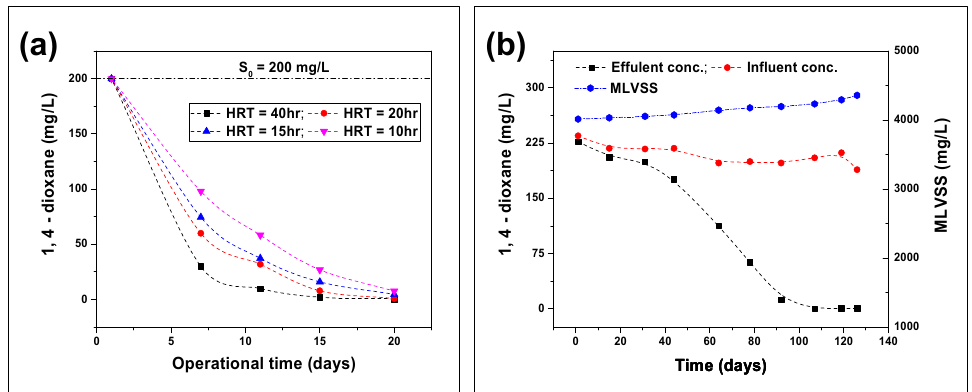
Figure 6. Lab-scale operation of the PFR plant for 1,4-dioxane biodegradation under a mixed culture grown on the BSM and sludge mixture using 1,4-dioxane as a substrate source: ( a ) HRT optimization at a biomass concentration of 3000 mg/L; ( b ) 1,4-dioxane biodegradation from industrial wastewater under long-term operation under optimized conditions. The results (CSTR and PFR) indicated that the mixed culture grown on sludge using 1,4-dioxane as a carbon source can be successfully used for the biodegradation of 1,4-di- oxane. The lab-scale results from the PFR test analysis show comparatively better perfor- mance in the biodegradation of 1,4-dioxane compared to the CSTR and results from other studies, as summarized in Table 3. Table 3. Comparative results summary of the biodegradation of 1,4-dioxane with previous studies based on source wastewater and treatment technology.